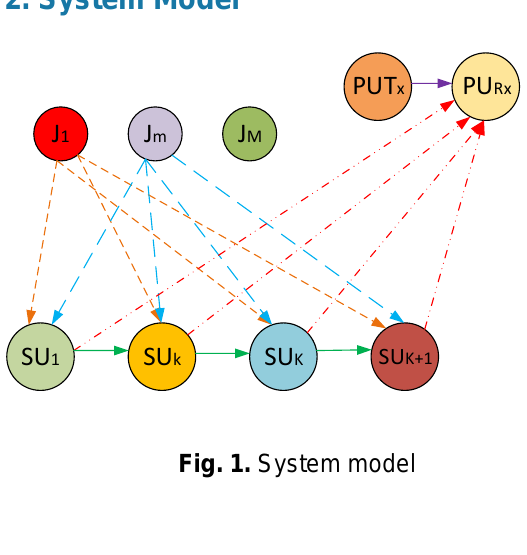
Energy harvesting links of the